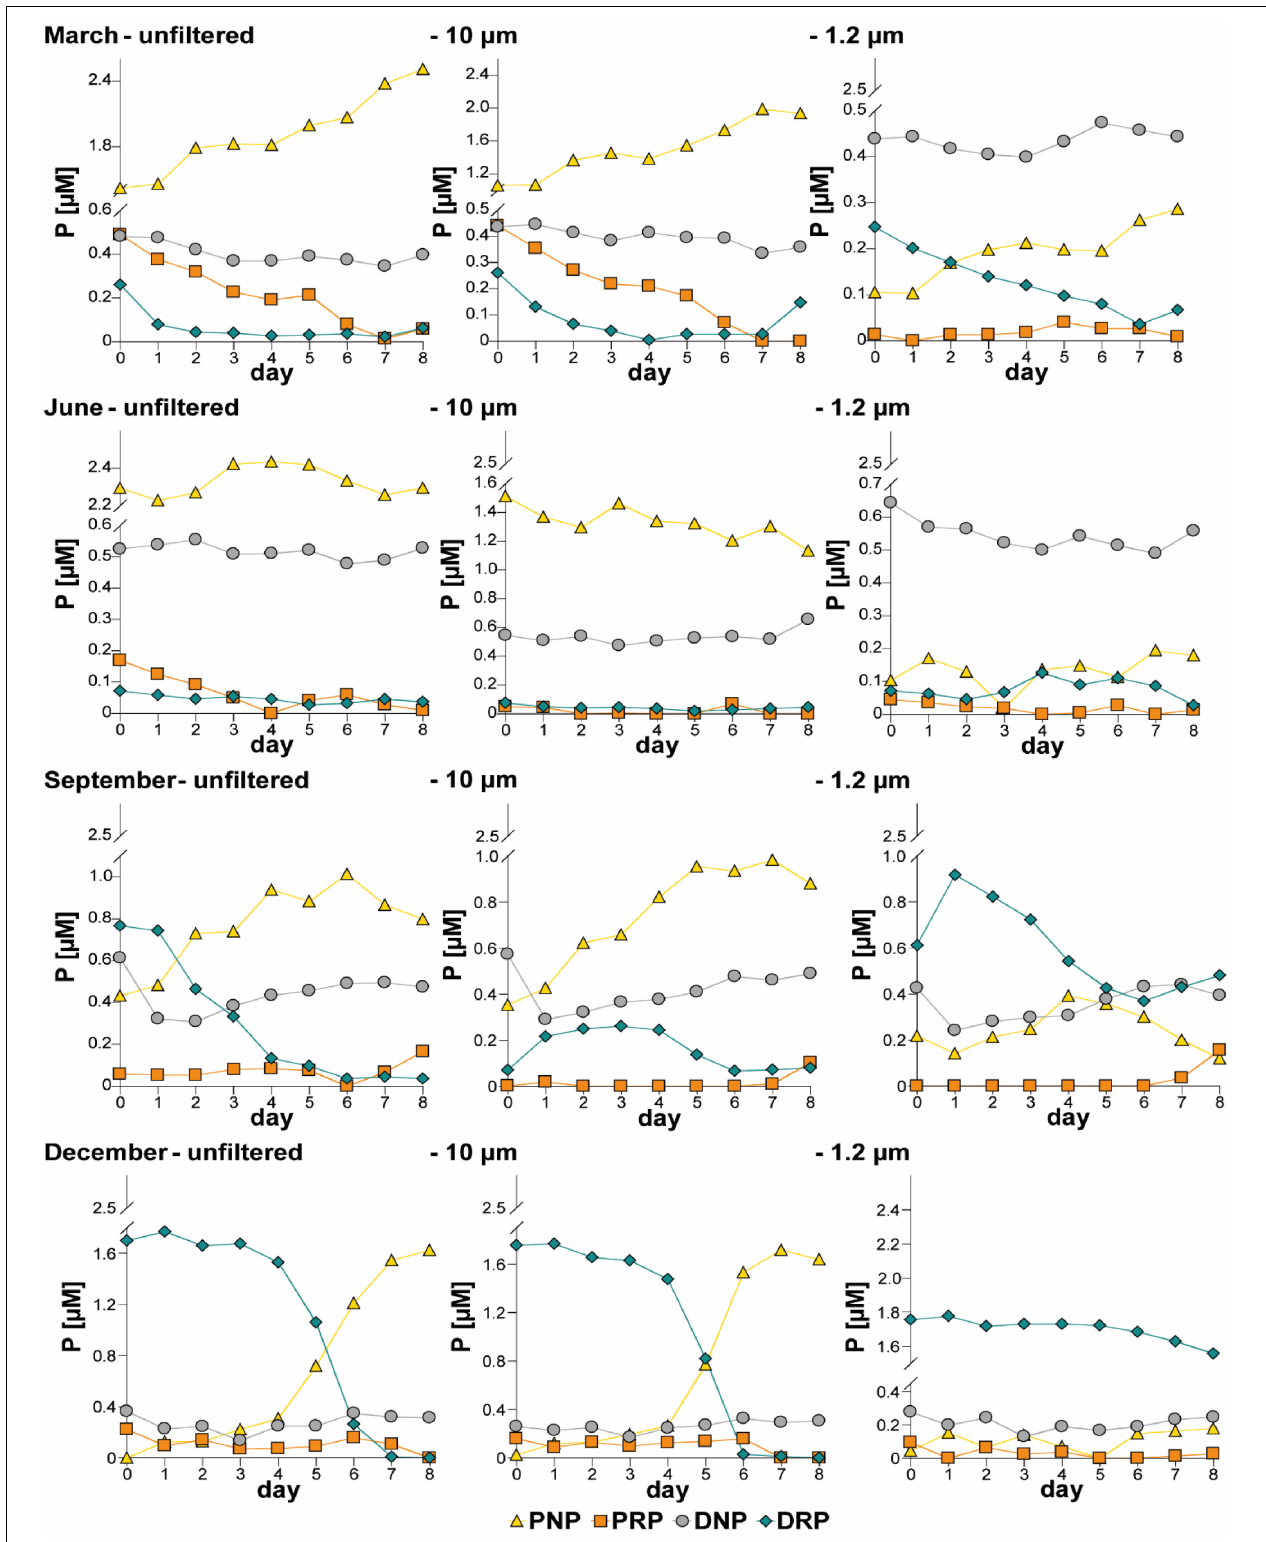
FIGURE 1 | Development of the phosphorus (P) fractions (median of triplicates) in all treatments (“unfiltered,” “10 µ m,” “1.2 µ m”) during the four experiments, DRP, dissolved molybdate-reactive P; DNP, dissolved non-molybdate-reactive P; PRP, particulate molybdate-reactive P; PNP, particulate non-molybdate-reactive P.